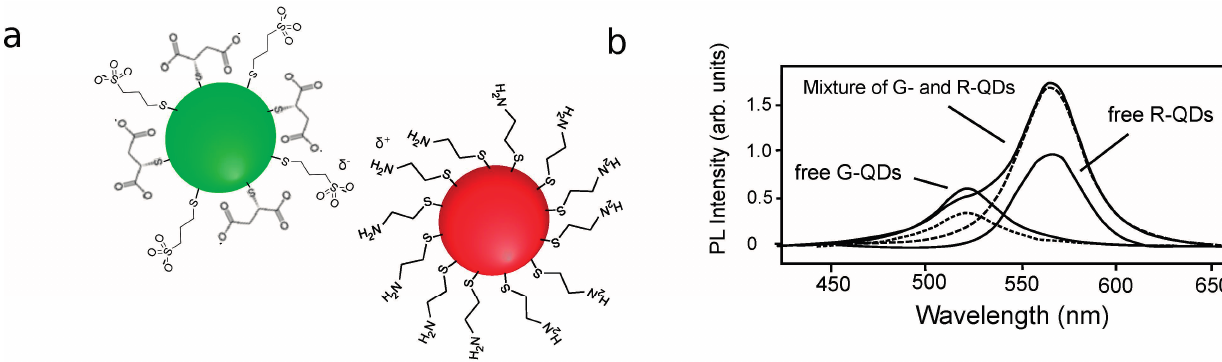
Figure 9. ( a ) Schematic of the QD-QD interactions induced by Wargnier et al . QDs coated with a mixture of mecaptosuccinic and mercaptosulfonic acids or cysteamine exhibited negative or positive surface charges, respectively. The opposing charges of these acid and amine terminal groups cause the QDs to aggregate. Schematic is not drawn to scale; ( b ) PL spectra for pure donor (G-QDs), pure acceptor (R-QDs), and mixed dots. The dotted lines represent the contributions from pure donor and acceptors to the mixed population PL; (b) reprinted with permission from [99]. Copyright (2004) American Chemical